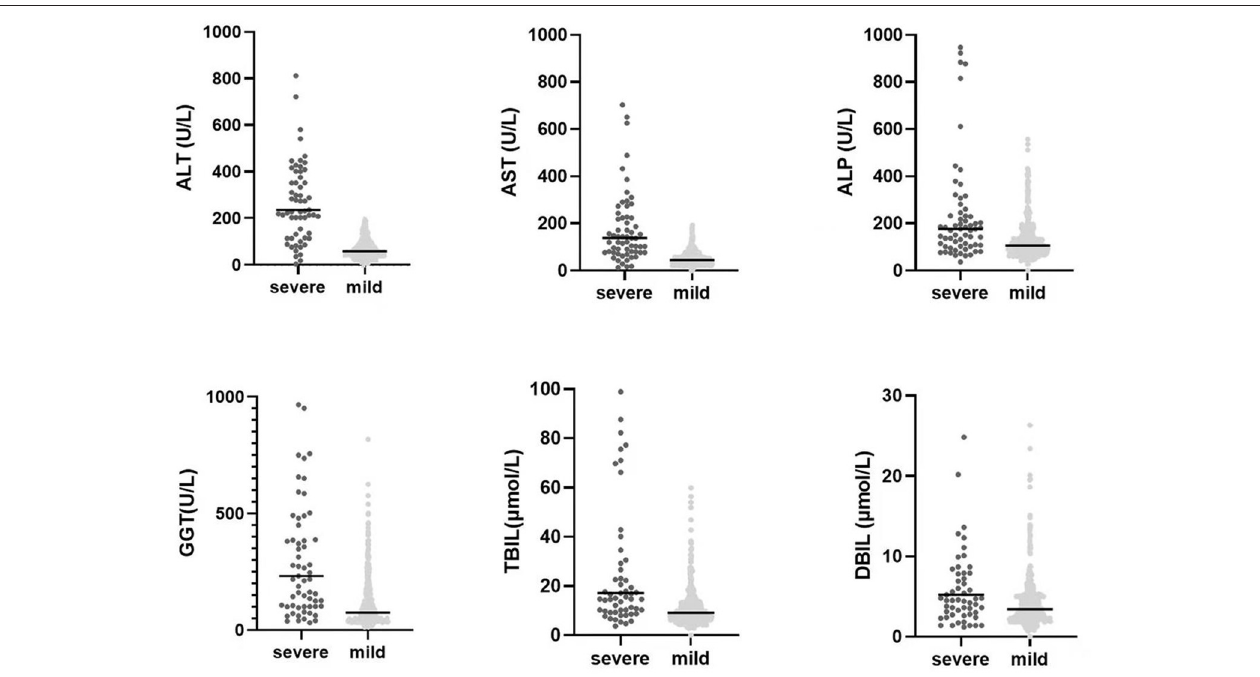
FIGURE 1 | The comparision of liver function tests levels between mild or moderate liver injury HIV-infected inpatients and severe liver injury HIV-infected inpatients. The P -values of all of six parameters were < 0.05 with statistically significant by using the Mann Whitney U